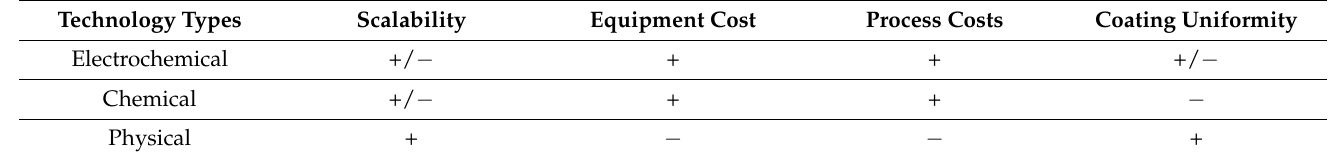
Figure 23. Classification of WO 3 fabrication technologies. Table 7. Comparison of three basic approaches to films WO 3 fabrication.